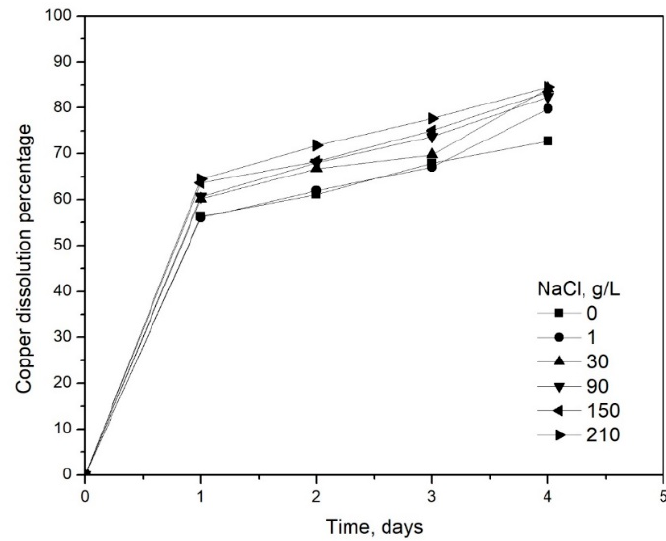
Figure 8. Copper recovery curves in leaching with a variation of NaCl, 20 g/L H 2 SO 4 , 4 g/L Fe 3+ under conditions of 1 atm, 22 °C and 400 rpm.